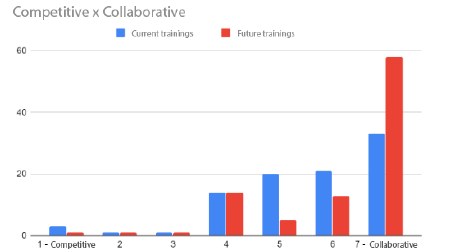
Figure 7. Vision of electricians and instructors about current and fu- ture trainings: competitive x collaborative.